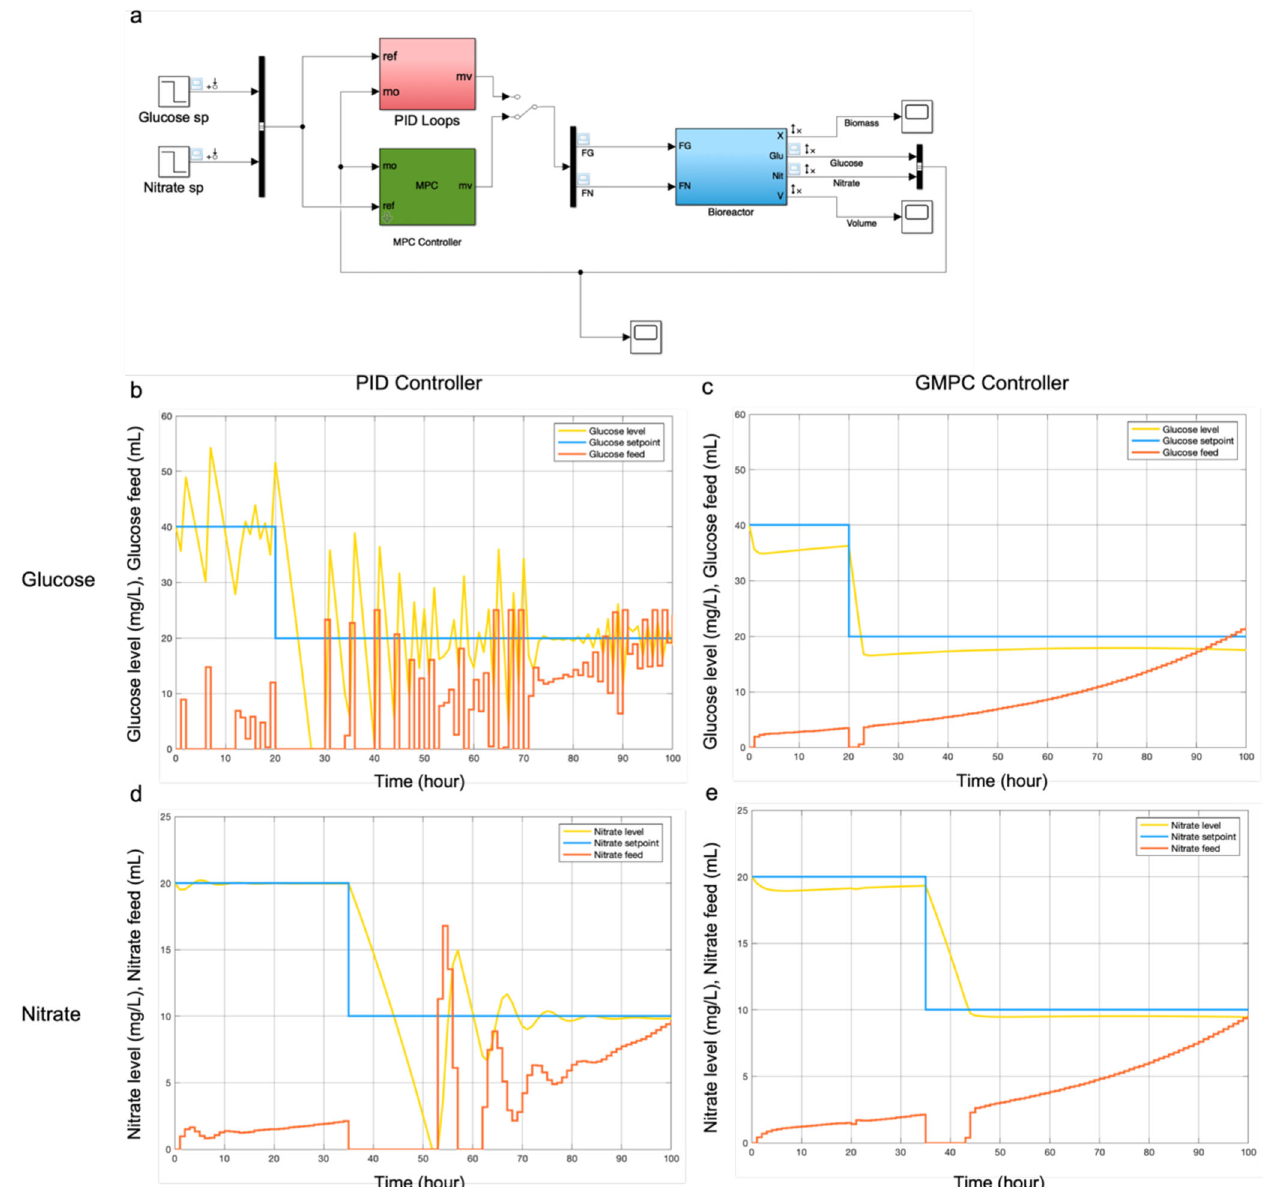
Fig. 5 Simulation of different process control algorithms. a Simulink model for model predictive control and PID control. Glucose control: b PID controller. c GMPC controller. Nitrate control: d PID controller. e GMPC controller.